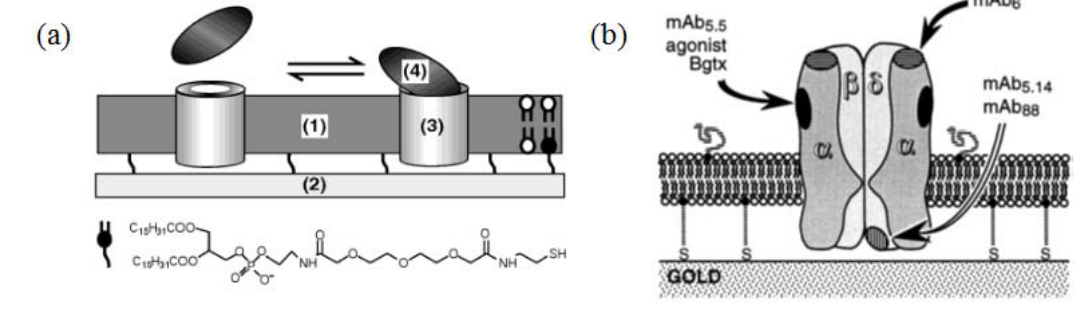
Figure 10. ( a ) Schematic illustrations of an OmpF (3) containing lipid bilayer tethered to a solid surface (2) and ligand interaction with the TR domain of colicin N. Reprinted with permission from Stora et al . [64] Copyright (1999) John Wiley & Sons, Inc. ( b ) nAchR reconstituted in a tethered bilayer: determining receptor orientation and functionality.